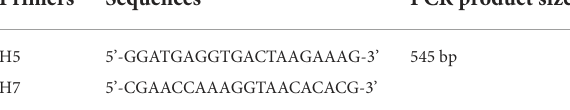
TABLE 4 Sequences of the primers for ALV-J. map, HB2020 clustered in the same region as the other ALV-J